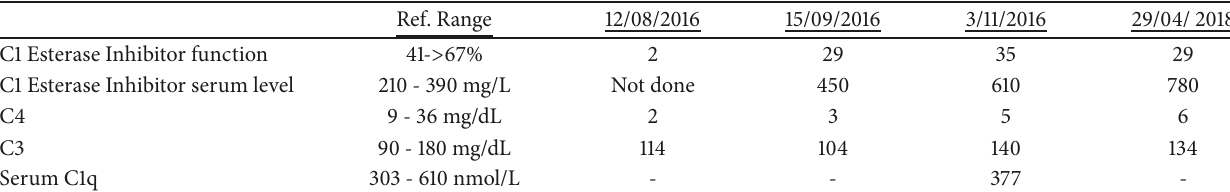
Table 1: Complement